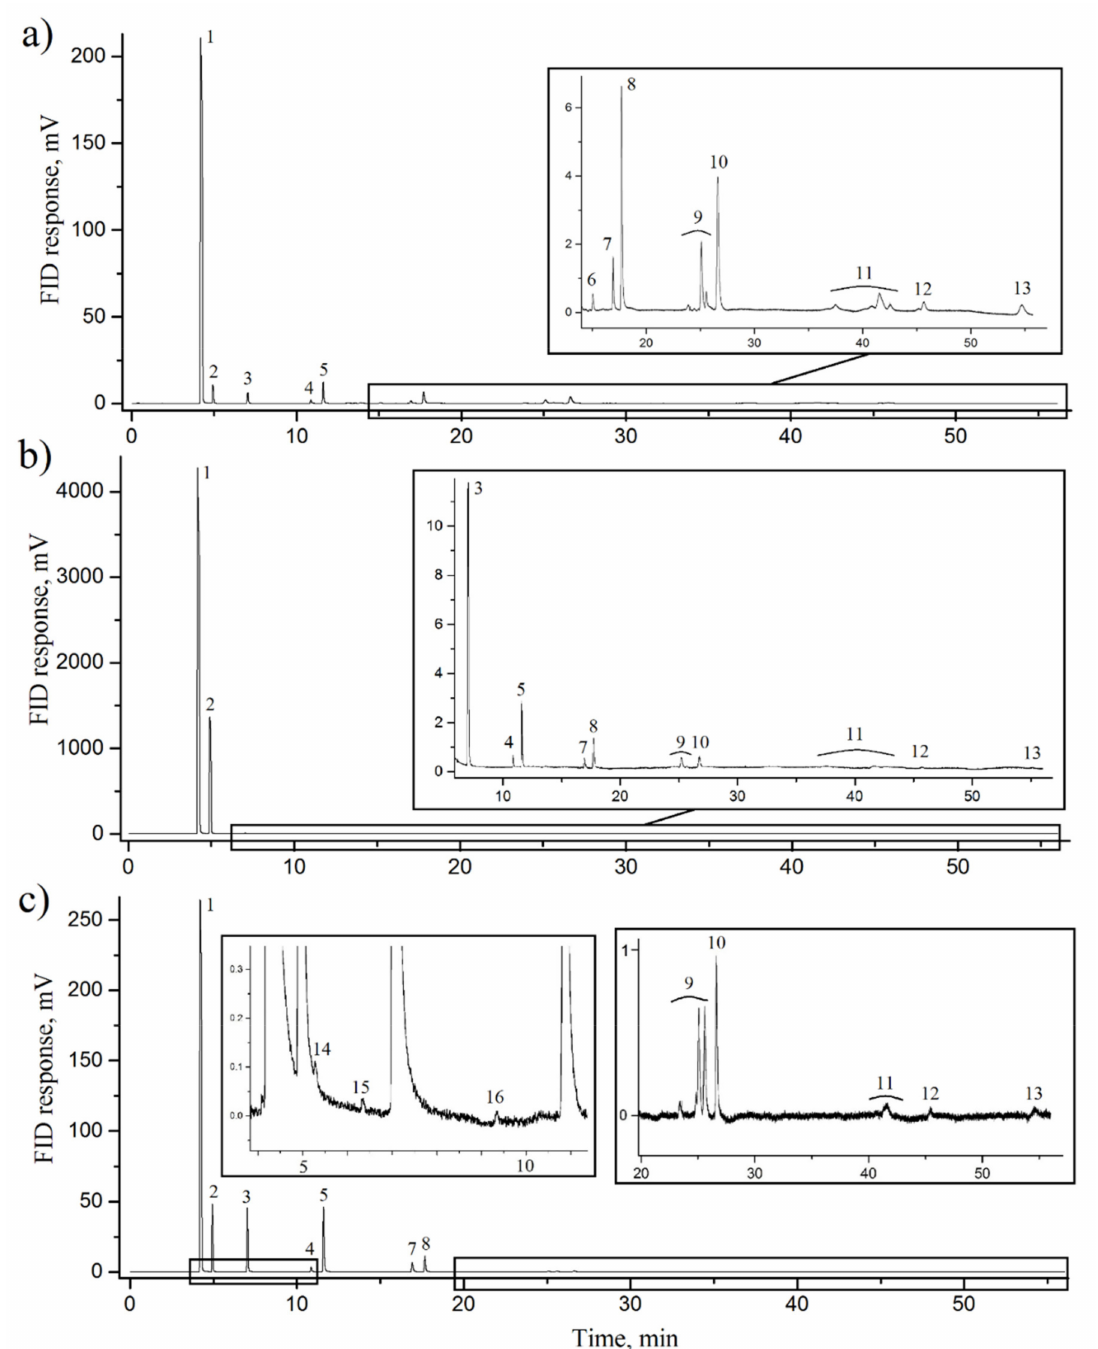
Figure 1. The chromatograms of hydrocarbon products formed from the chemical reaction of iron carbide and water at ( a ) 2.5 GPa and 873 K; ( b ) 3.5 GPa and 1123 K; ( c ) 6.0 GPa and 1223 K. 1—methane, 2—ethane, 3—propane,